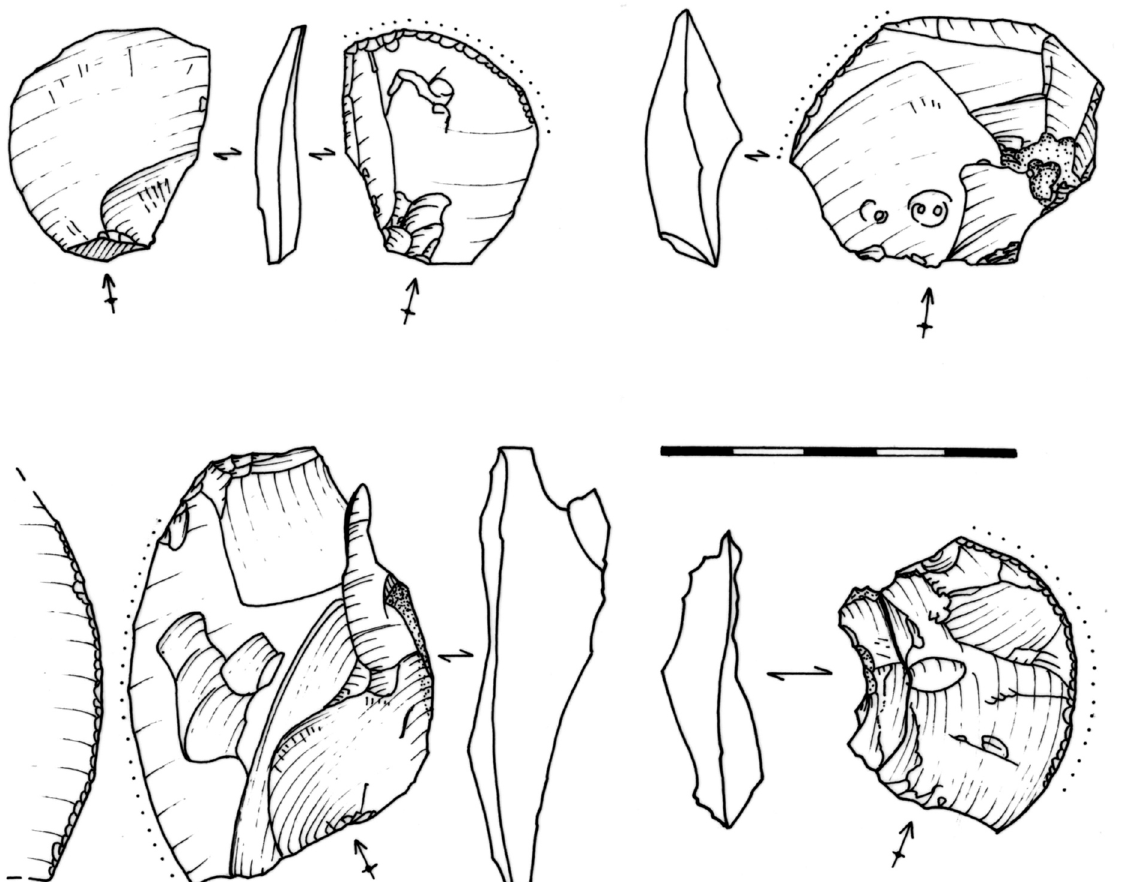
Figure 11. Eclats Kombewa à retouche raclette du site de d’Aubevoye, »La Chartreuse » (Eure). Dessin de D. Prost. Figure 11. Kombewa flake with à « raclette » retouch from Aubevoye site « La Chartreuse » (Eure). Drawing by D.